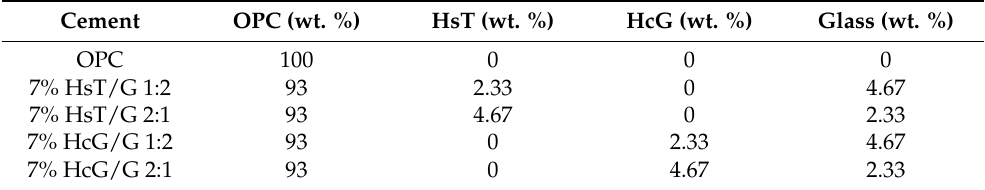
Table 1. Cement nomenclature.